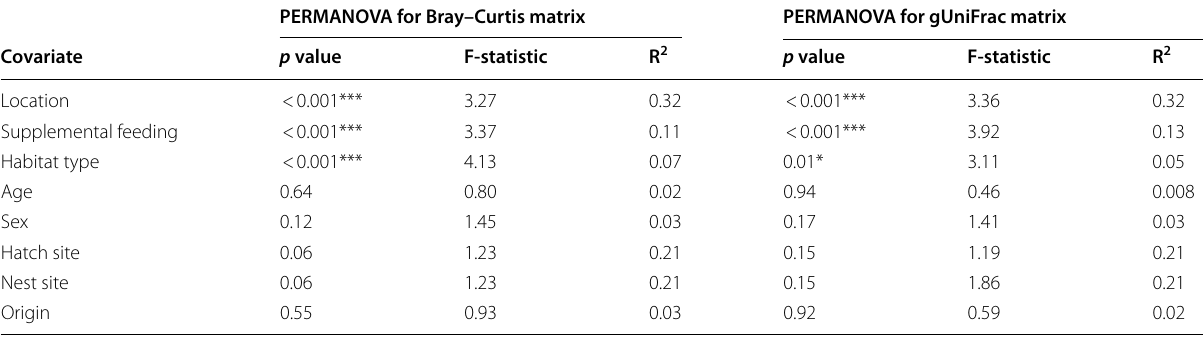
Table 1 Statistical outputs for beta-diversity Bray–Curtis and gUniFrac matrices using PERMANOVA analyses performed with 9999 permutations